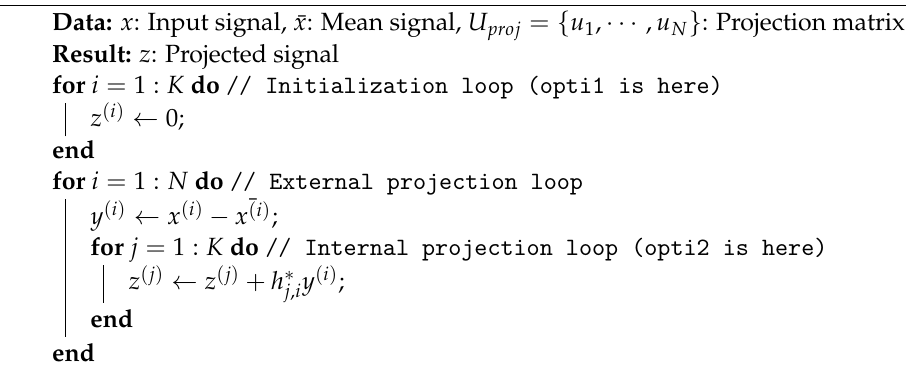
Algorithm 2: Pseudocode of FPGA implementation